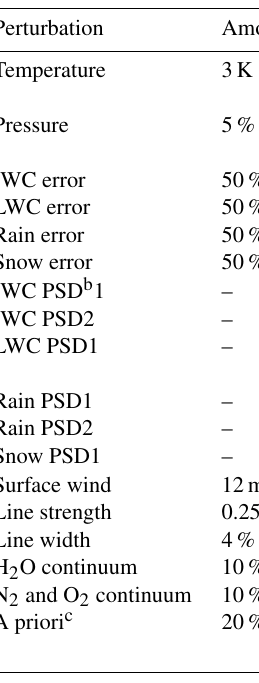
Table 2. Systematic uncertainties perturbations a